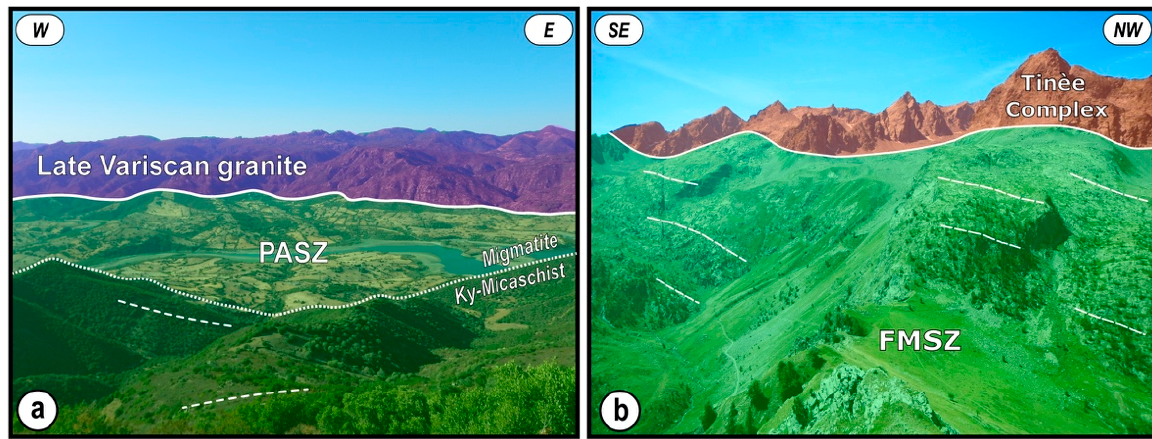
Figure 4. Panoramic view of two branches of the EVSZ, where the white dashed lines represent the